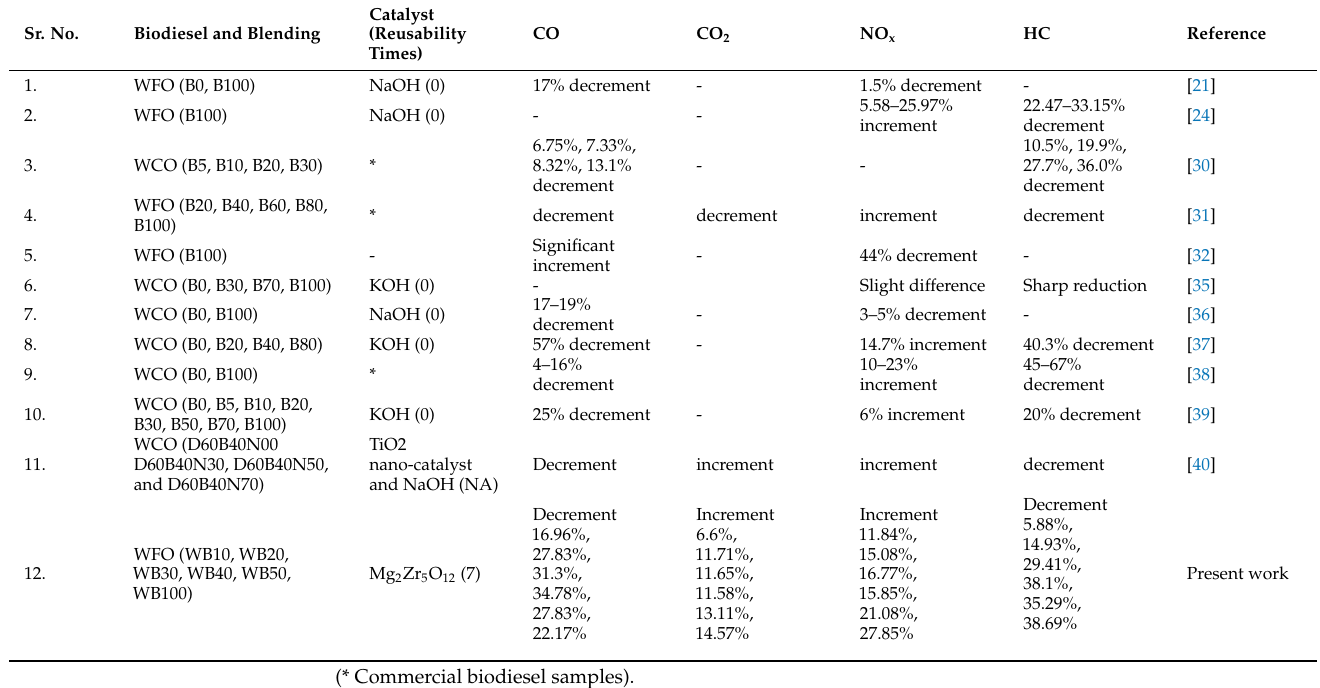
Table 5. Comparison of engine emission with respect to diesel fuel based on previous work.